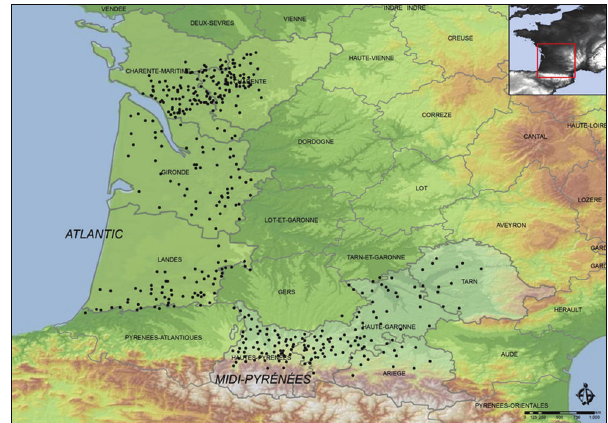
Figure 1: Location of the 443 ANELFA hailpad stations in continu- ous use between 1990 and 2010, used in the